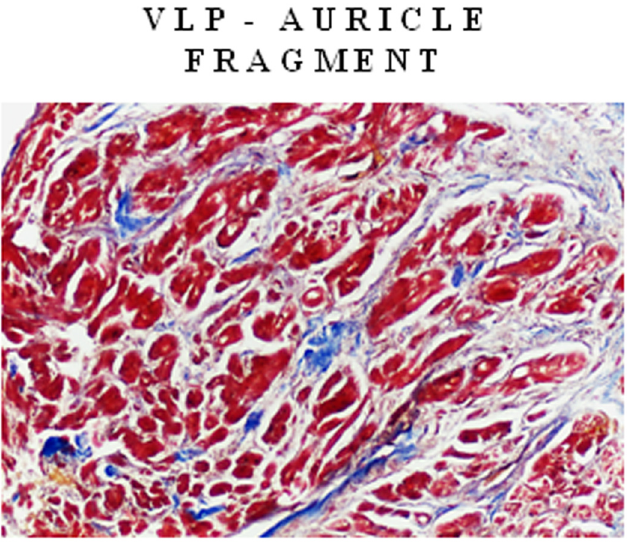
Fig 7. Hystology. Histological representation (Masson ’ s trichrome) of auricle in